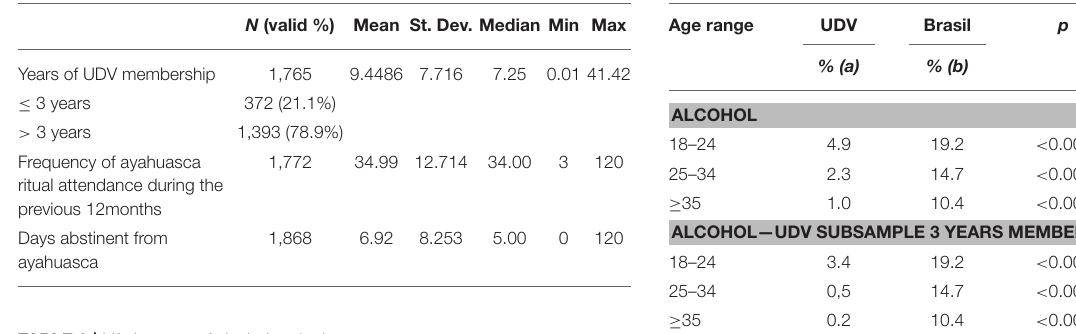
TABLE 3 | Lifetime use of alcohol and tobacco.